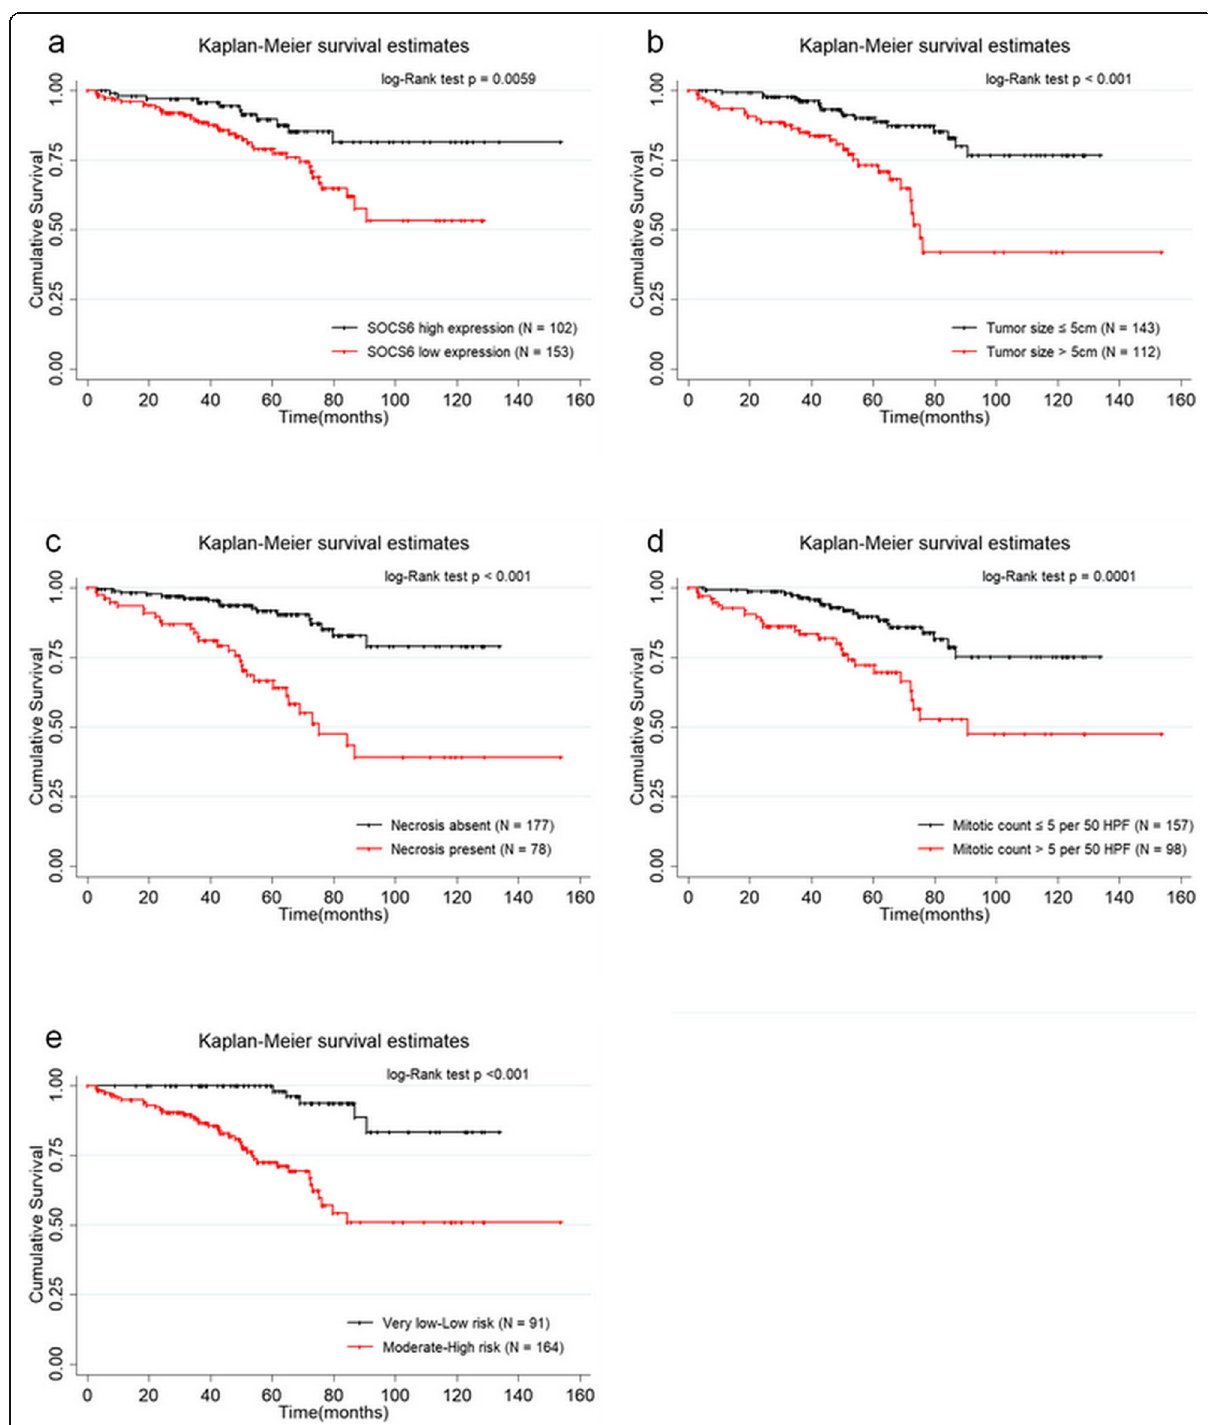
Fig. 3 The impacts of SOCS expression, tumor size, necrosis of tumor, mitotic index, NIH risk grade on OS assessed according to Kaplan-Meier curve analysis and log-rank test. A Impact of SOCS6 expression on OS of GIST patients. B The impact of tumor size on OS of GIST patients. C The impact of necrosis of tumor on OS of GIST patients. D The impact of mitotic index on OS of GIST patients. E The impact of NIH risk grade on OS of GIST